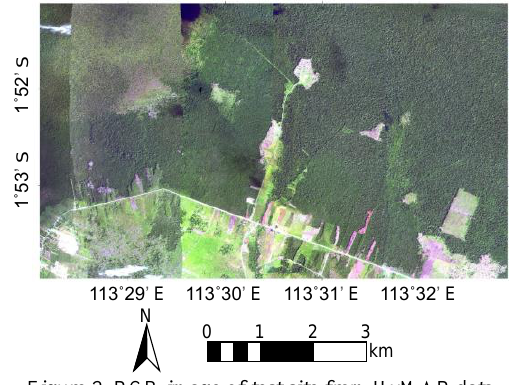
Figure 2. RGB image of test site from HyMAP